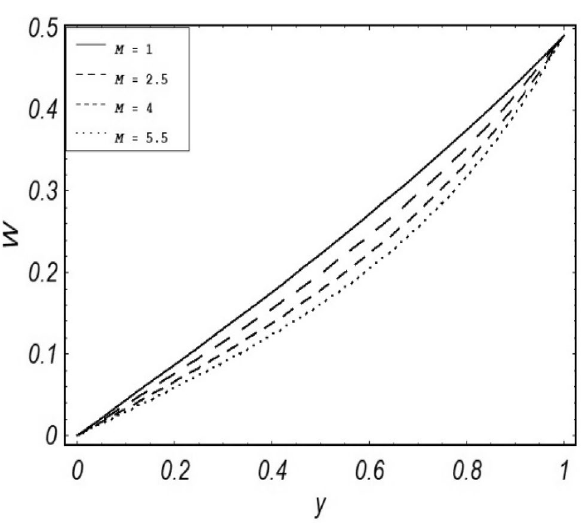
Figure 10. Evolution of W with various values of M if t = 1 ; Gr = 2.5 ; K 1 = 0.5 ; N = 1 ; η = 0.2 ; m = 0.5